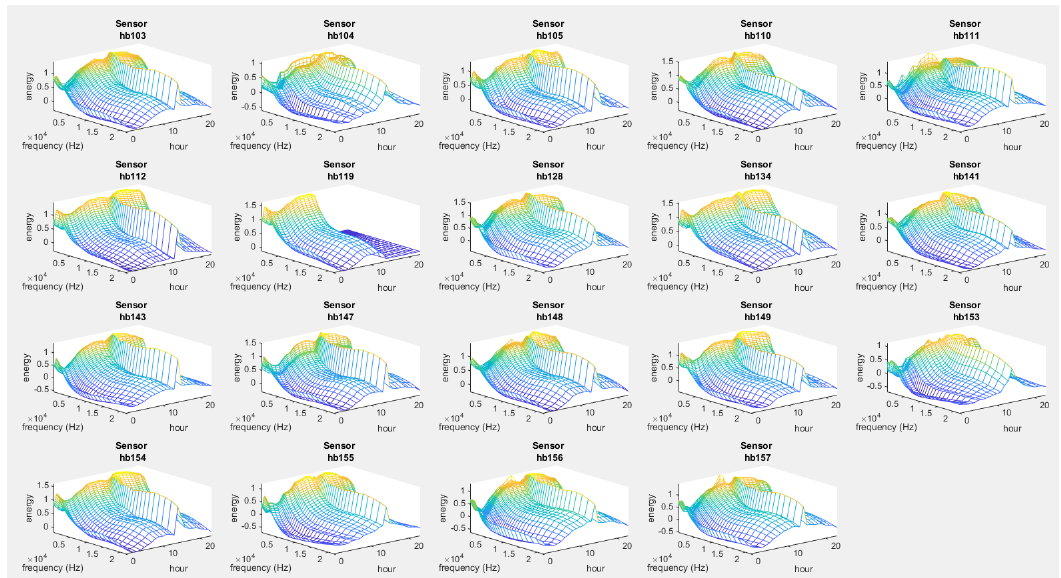
Figure 4. Spectrum-time profiles of the 19 sensors of the WASN during the weekend (5 November 2017).